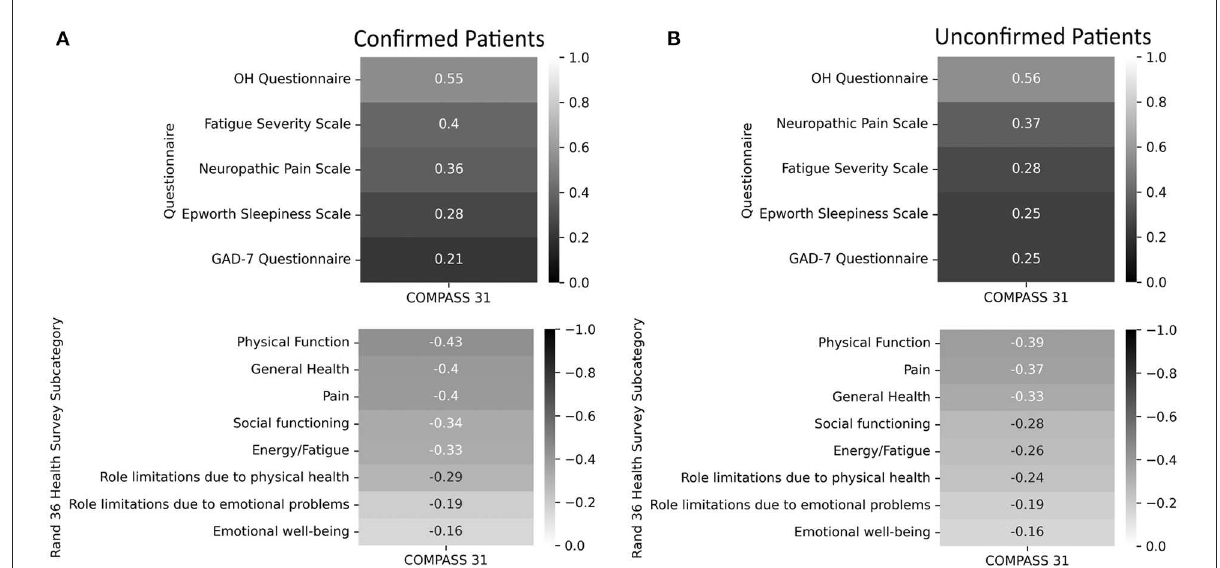
FIGURE3 Correlations of the Fatigue Severity Scale, Neuropathic Pain Scale, Epworth Sleepiness Scale, General Anxiety Disorders Assessment, Orthostatic Hypotension Questionnaire, and the Rand-36 to total COMPASS-31 scores. A lower score on the RAND 36-Item Health Survey indicates greater disability. (A) Confirmed participants. (B) Unconfirmed